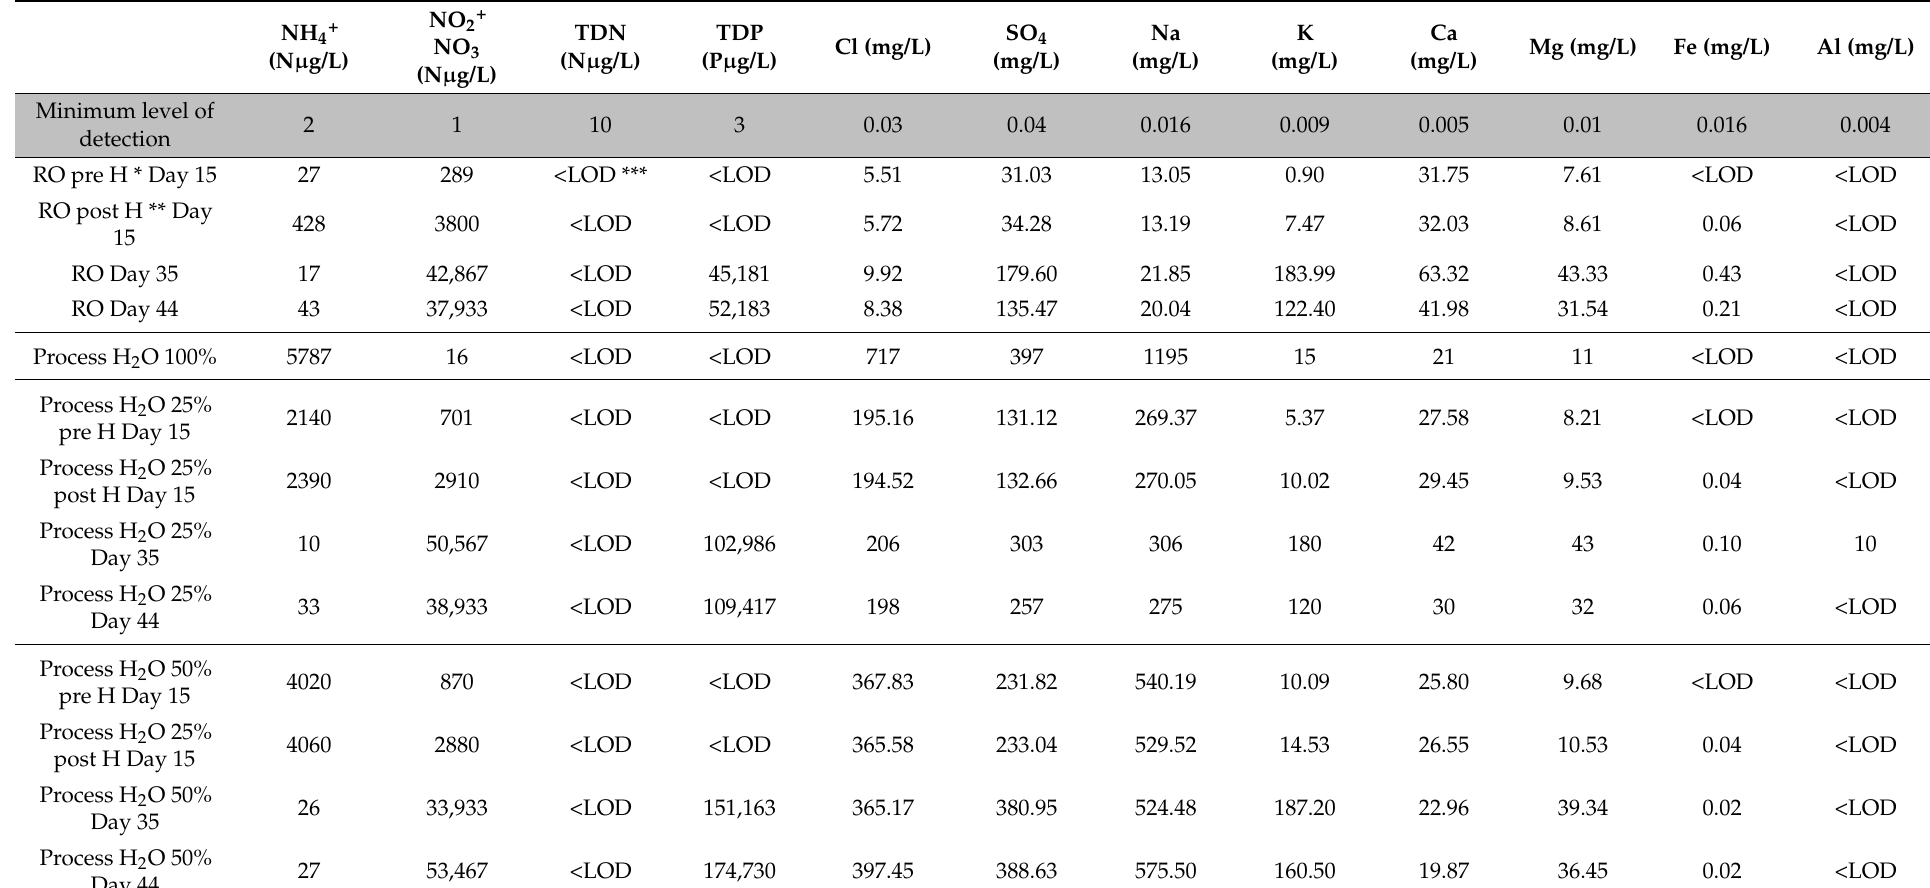
Table 2. Results of analysis of the water solution (means) for the control (reverse osmosis: RO), 25% process water treatment (process H 2 O 25%), and 50% process water (process H 2 O 50%) treatments before and after the addition of Hoagland’s solution (day 15), day 35, and day 44 in 2012. Values for undiluted process water (process H 2 O 100%) are shown for comparison. Note: TDN = total dissolved nitrogen; TDP = total dissolved